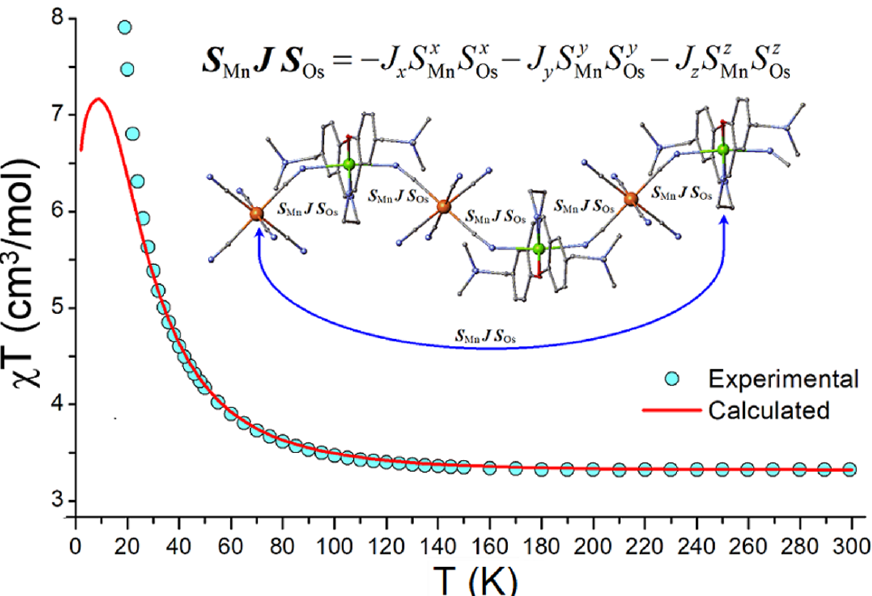
Figure 4. Experimental (blue circles) and simulated (solid red line) magnetic susceptibility χ T of 1 . The χ T curve was simulated with the spin Hamiltonian (2) involving anisotropic triaxial spin coupling S Mn J S Os = − J x S Mn x S Os x − J y S Mn y S Os y − J z S Mn z S Os z . The best fit is obtained at the set of parameters J x = − 22, J y = +28, J z = − 26 cm − 1 , g Mn = 2.02, g Os =1.80, D Mn = − 3.6 cm − 1 . Calculations are performed for a six ‐ membered fragment {Mn ‐ Os} 3 of the heterometallic chain of 1 with cyclic boundary conditions for the Mn ‐ Os spin coupling, as shown in the inset.